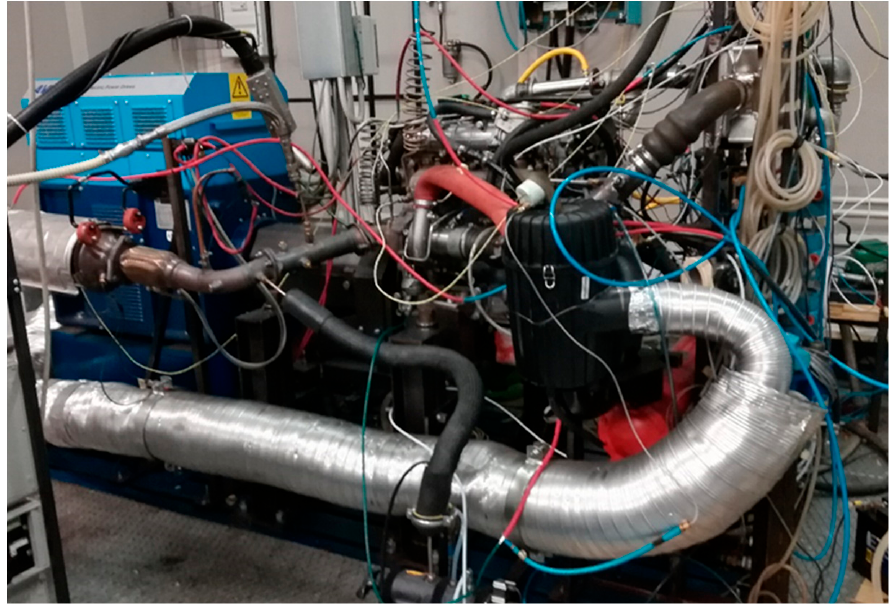
Figure 3. IVECO F1C 3-L supercharged diesel internal combustion engine.